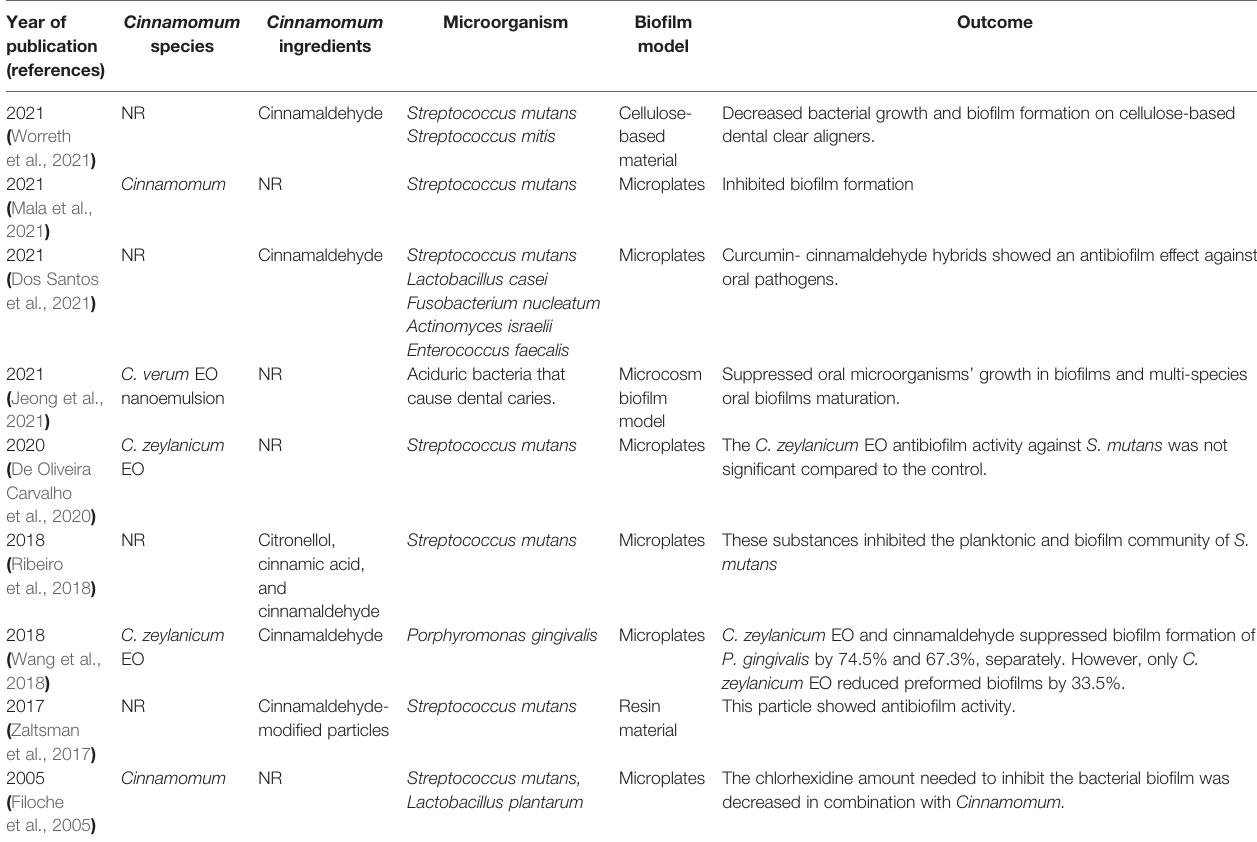
TABLE 2 | Antibio fi lm effect of Cinnamomum and its derivative compounds against bio fi lm of bacteria associated with dental